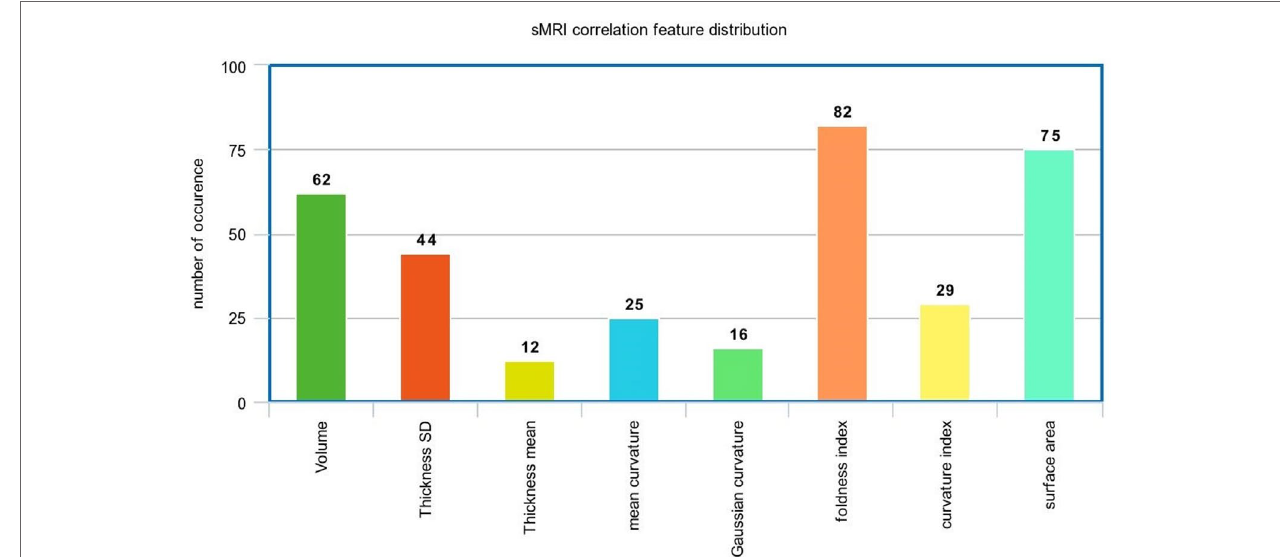
FIGURE 6 | The frequency of occurrence of each of the sMRI features in the significantly correlated features list with ADOS overall score.